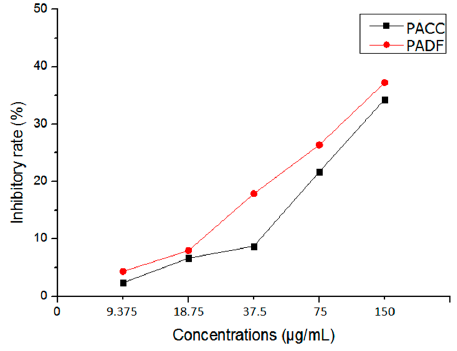
Figure 3. The cytoxicity of PACC and PADF on the proliferation of BEL-7402/5-FU.